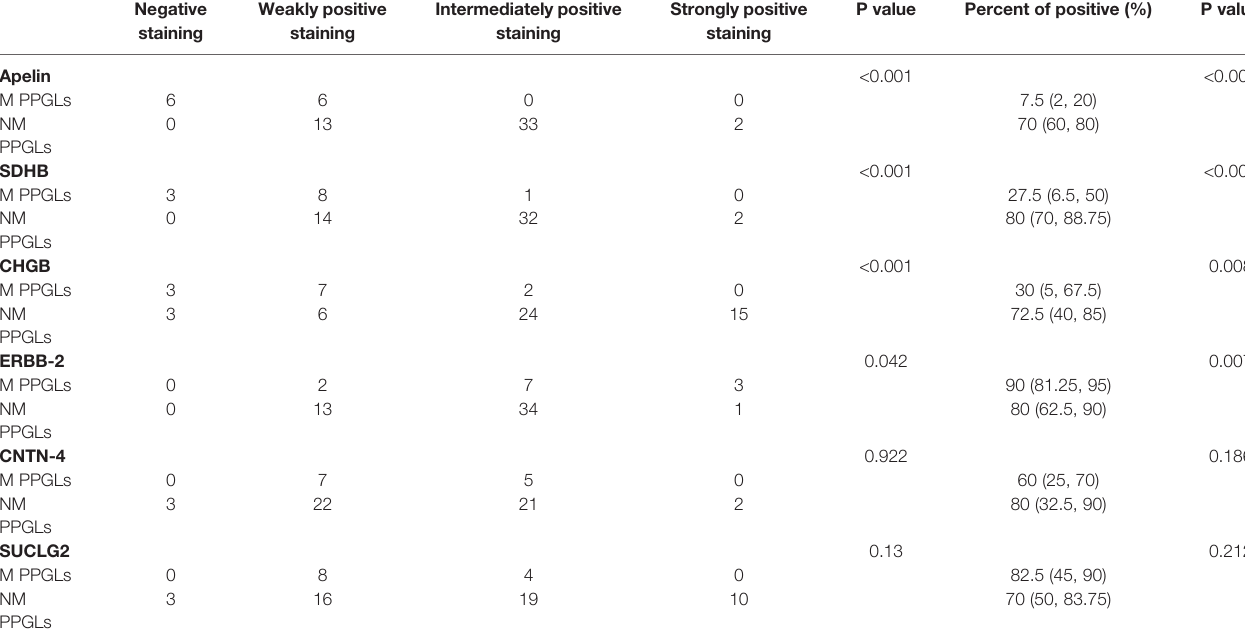
TABLE 2 | The IHC expression of Apelin, SDHB, CHGB, ERBB-2, CNTN4 and SUCLG2 in PPGLs. Negative Weakly positive Intermediately positive staining staining staining